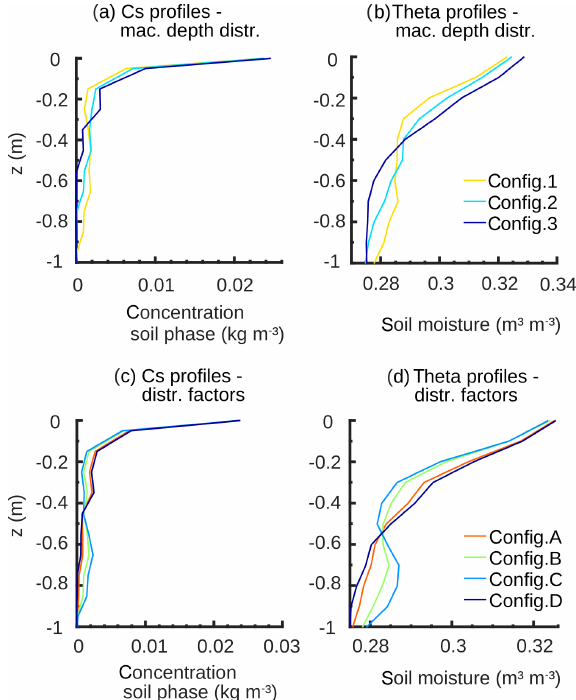
Figure 9. Final simulated bromide concentration (Cs) and soil moisture (theta) profiles of the soil matrix at different macropore diameters (dmac) (a, b) and macropore numbers (nmac) (c, d) .